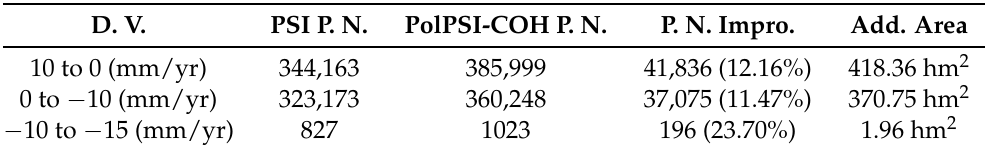
Table 3. Statistical analysis of PSI and PolPSI-COH obtained ground deformation results over Fukang